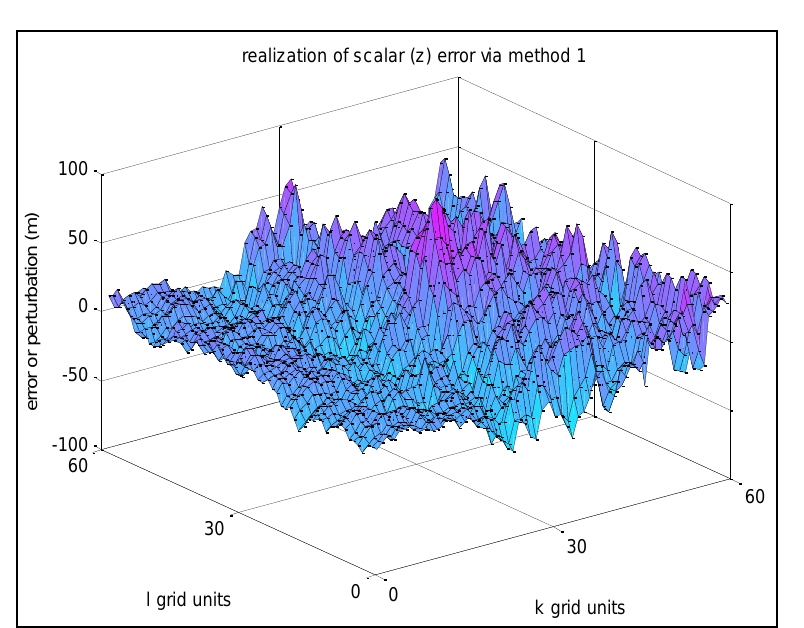
Figure 17. A smooth transition from Region 1 to Region 2 , each with their own specified a priori